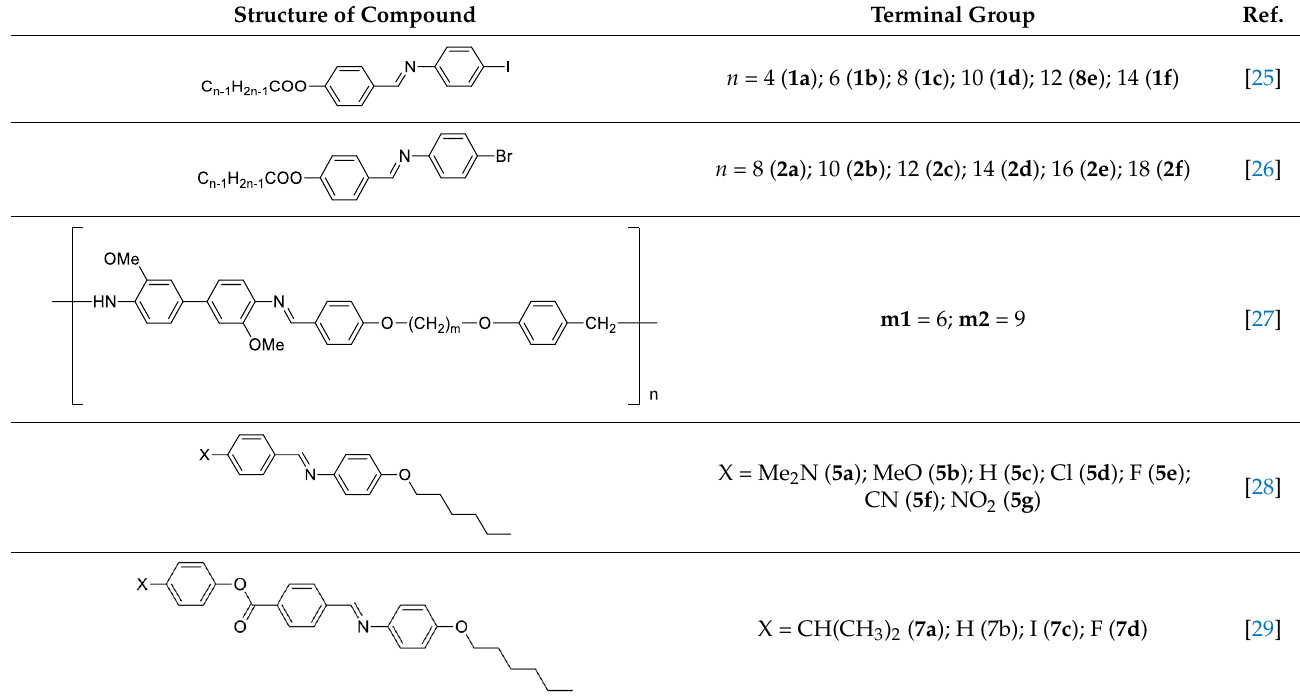
Table 1. Schiff base compounds attached to different terminal ends.